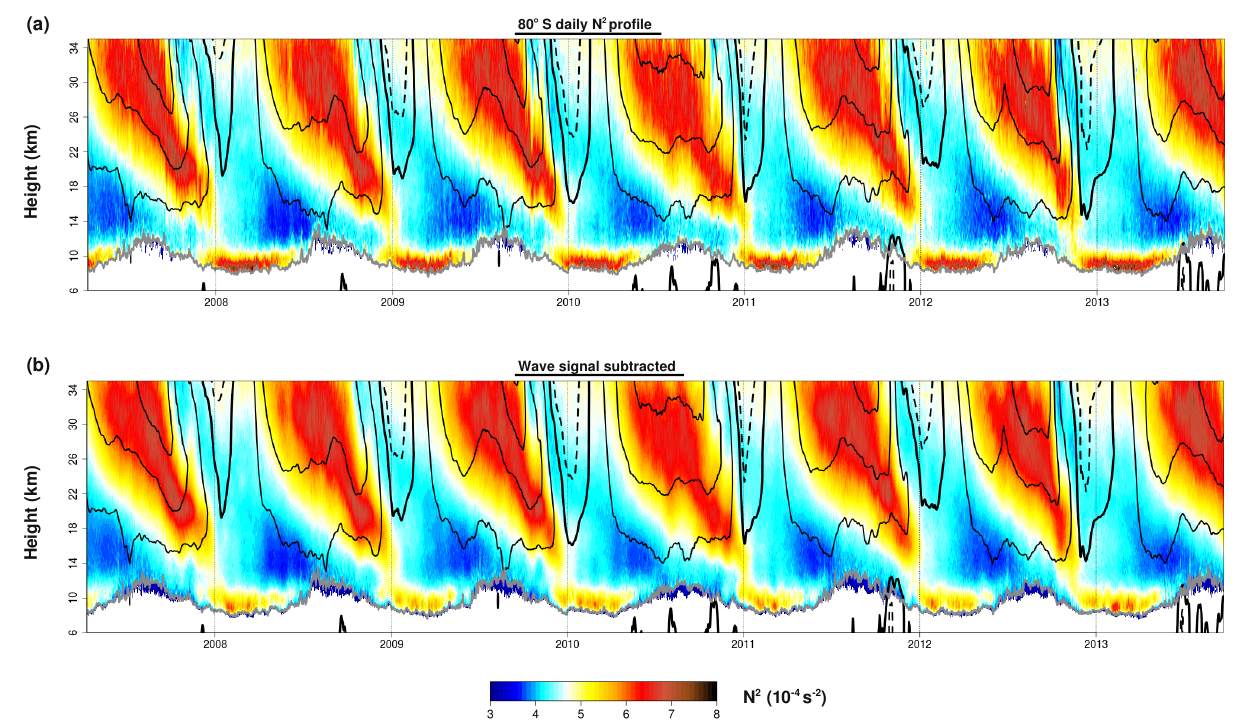
Figure 9. As in Figs. 5 and 7, but for 80 ◦ S. The first easterly wind contour (dashed line) is at − 3ms − 1 for better visibility. The rest of the wind contours are 10ms − 1 intervals as in Fig.